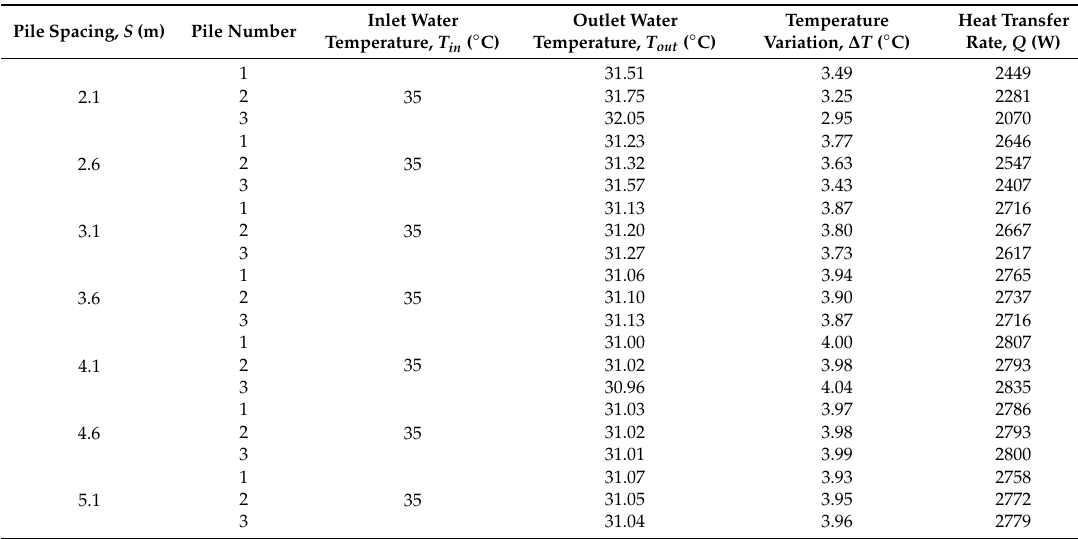
Figure 11. Outlet water temperature variation for di ff erent pile spacings, S , for the energy pile group with a deeply penetrating 1-U-shaped heat exchanger after 720 h. Table 9. Simulation results for di ff erent pile spacings, S (keeping all other values consistent with the reference values in Table